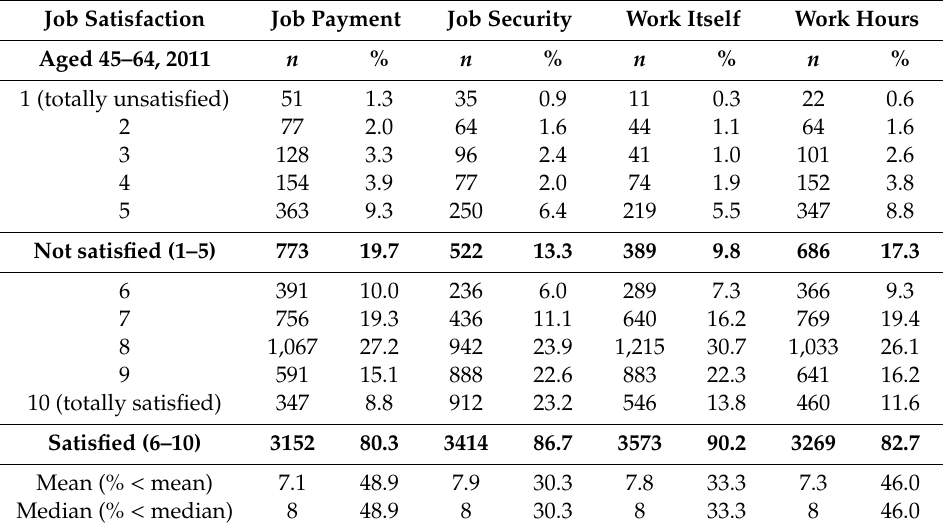
Table A1. Distribution of job satisfaction for Australian workers aged 45 and